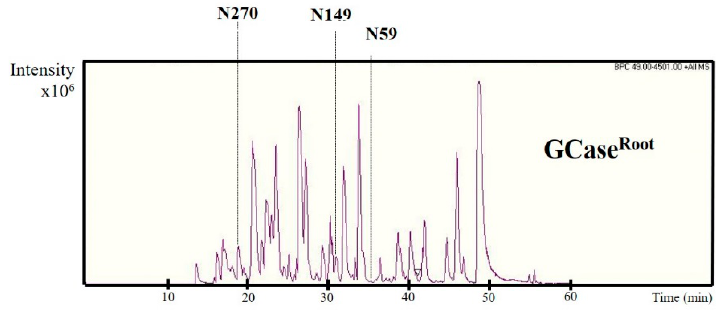
Figure 4 . The spectra of glycopeptides derived from purified GCase extracted from root culture . The purified GCase was digested with trypsin and injected to a nano LC-MS / MS . N represents the N -glycosylation site at positions 270, 149 and 59 .